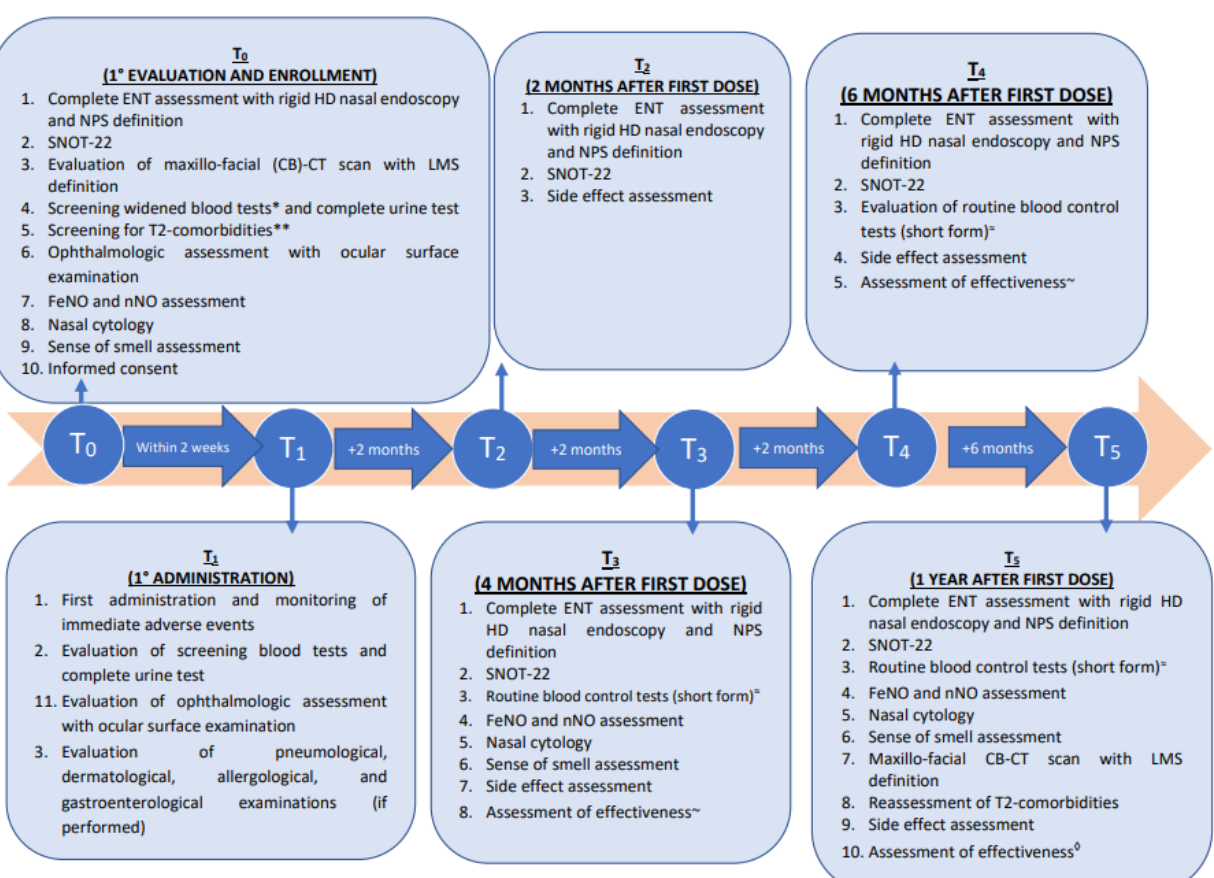
Figure 2. Flow-chart describing the diagnostic and therapeutic program scheduled for patients with severe chronic rhinosinusitis with nasal polyps (CRSwNP) and who are candidates for dupilumab. Abbreviations: ENT: ear, nose, and throat; NPS: Nasal Polyp Score; LMS: Lund–Mackay score; SNOT-22: SinoNasal Outcome Test score; CB-CT: cone-beam computed tomography; FeNO: fraction of exhaled nitric oxide; nNO: nasal nitric oxide. *: including complete blood count and differential, lymphocyte subpopulation analysis, eosinophils count; complete liver enzymes; serum protein; serum creatinine; serum reactive C-protein; serum IgA, IgG, IgM, IgE level; serum peri-nuclear antineutrophil cytoplasmatic antibodies, extractable nuclear antigens; creatine phosphokinase serum level, eosinophil cationic protein serum level; **: in case of suspected or known T2-related comorbidities address the patients to further (dermatological, allergological, pneumological, and gastroenterological) assessments; ~: based on documented improvement in NPS and/or SNOT-22 and/or sense of smell assessment; ≈ : including complete blood count and differential, eosinophils count; serum IgE level; eosinophil cationic protein serum level; ♦ : based on documented improvement in NPS and/or SNOT-22 and/or sense of smell assessment and/or LMS and/or